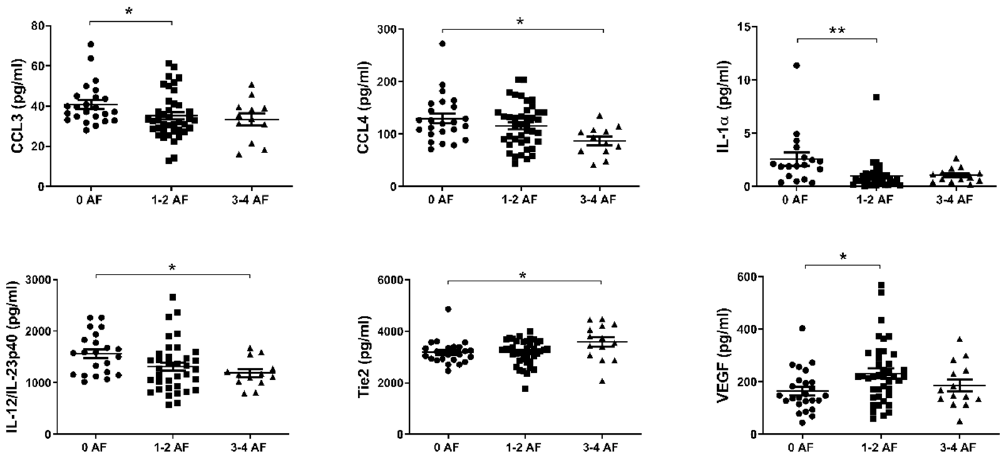
Figure 4. In EAC patients with no adverse features of tumor biology, CCL3, CCL4, IL-1 α , and IL-12 / IL-23p40 levels were higher in serum, with the contrary evident for Tie2 and VEGF. Groups were divided according to adverse features of tumor biology, with groupings of 0 adverse features, 1–2 adverse features or 3–4 adverse features. Data were analyzed by ANOVA (Kruskal–Wallis test with Dunn’s multiple comparisons). * p < 0.05. ** p < 0.01. IL = Interleukin, VEGF = Vascular Endothelial Growth Factor.